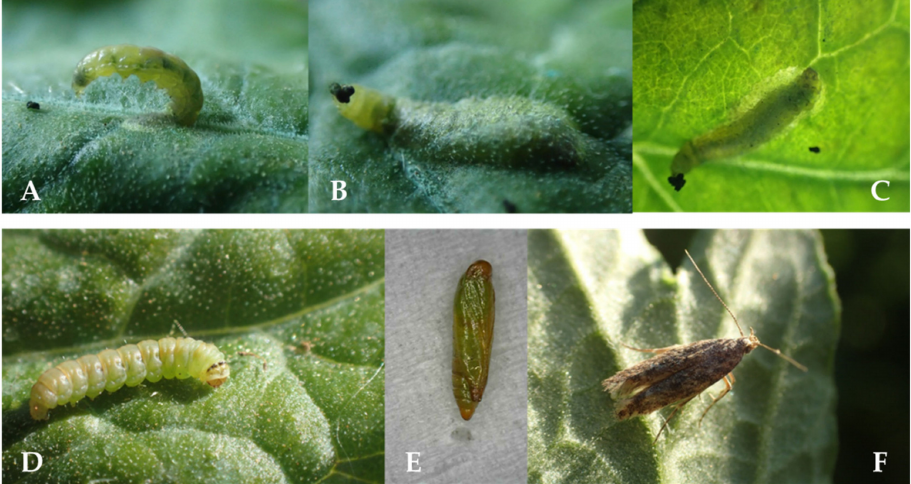
Figure 2. Tuta absoluta development stages: larva ( A – D ), pupa ( E ) and adult ( F ). Details of larval mining under leaf surface on A – C